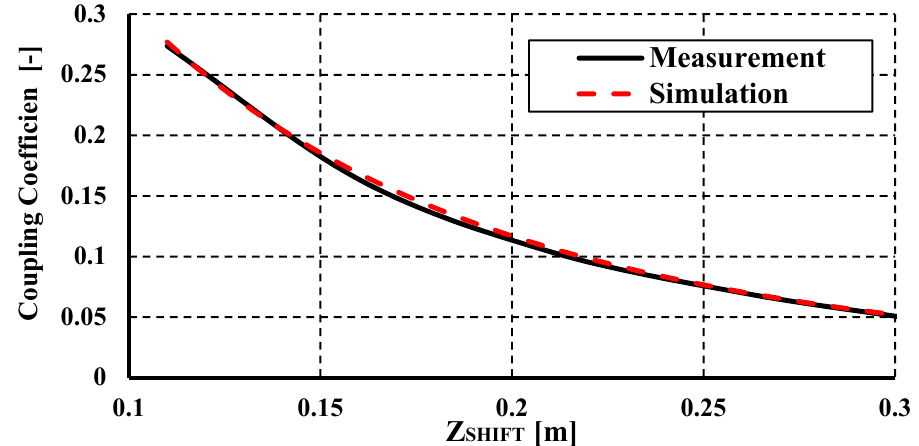
Figure 5. Model verification—Coupling coefficient dependency on transfer distance.